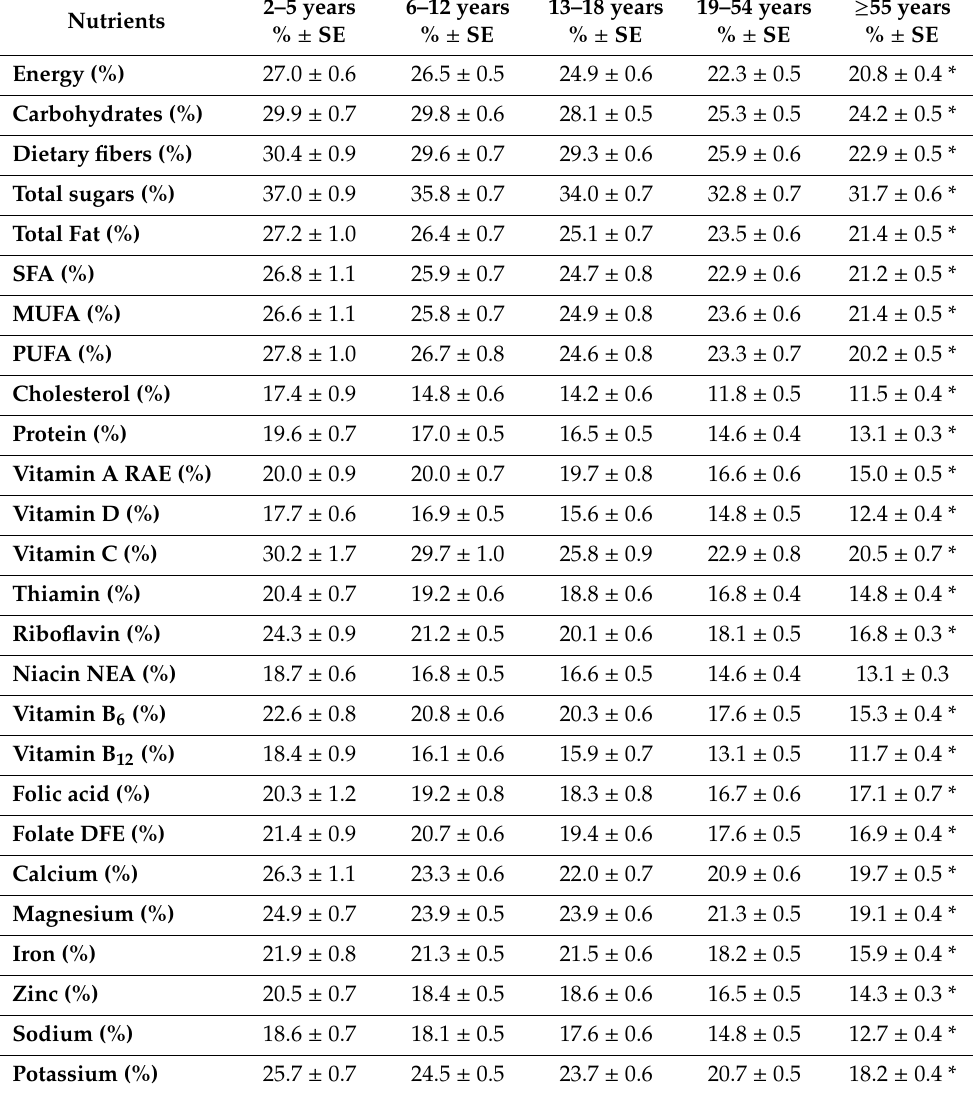
Table 3. Relative contribution of snacks to daily energy and nutrient intake across the five age groups among snack consumers 1